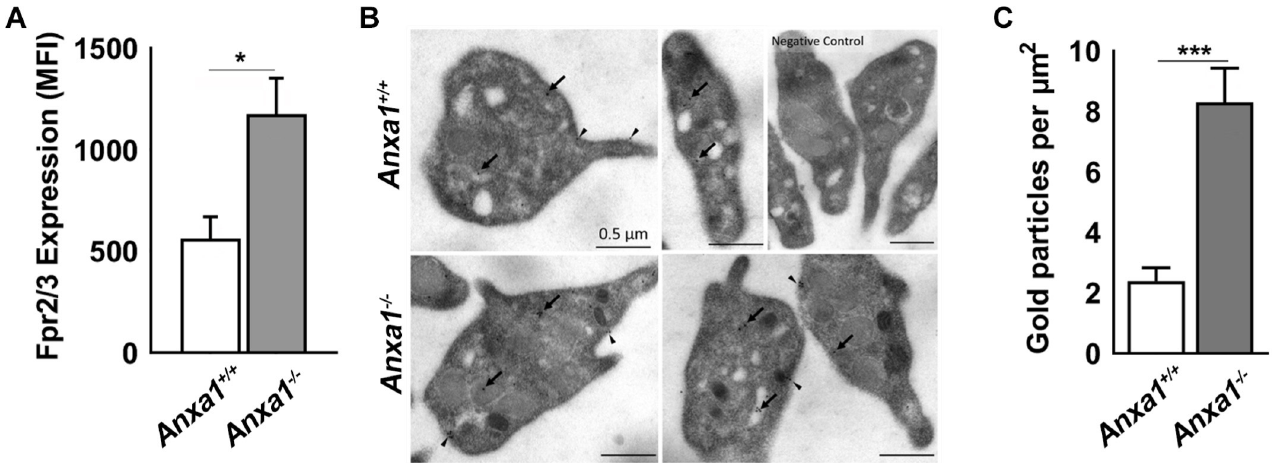
Figure 3. The expression of Fpr2/3 in Anxa1 − / − mouse platelets. ( A ) The expression levels of Fpr2/3 were measured using selective antibodies by flow cytometry in platelets obtained from control and Anxa1 − / − mice. ( B ) Ultrastructural localisation of Fpr2/3 was analysed in platelet sections using selective antibodies against Fpr2/3 and immunogold particles-conjugated secondary antibodies. The electron micrographs shown are representative of experiments performed with four separate mice in each group. The antibody binding to specific locations in the cytosol (arrows) and plasma membrane (arrowheads) is shown in comparison to control mouse platelets. The negative control images show the ultrastructure of platelet sections that were treated with secondary antibodies but in the absence of primary antibodies. ( C ) The density of Fpr2/3 immunogold particles in platelets as quantified using electron micrographs. Data represent mean ± S.D. ( n = 4 for A ; multiple images from 4 mice in each group for C ). The p values shown (* p < 0.05 and *** p < 0.001) are calculated by a paired Student t -test for ( A ) and a non-parametric Mann–Whitney test for ( C ).